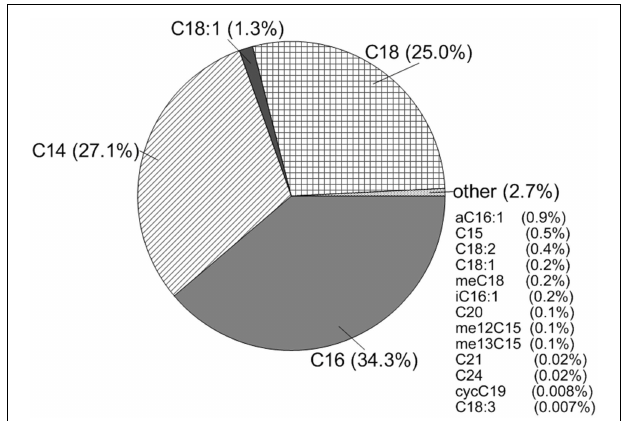
FIGURE 2 | Lipid composition of the water at Crystal Geyser.